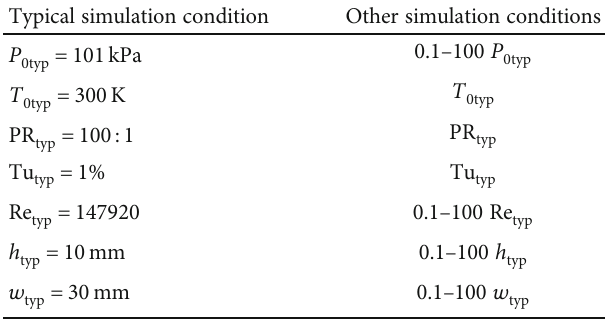
Table 1: Simulation setup parameters.